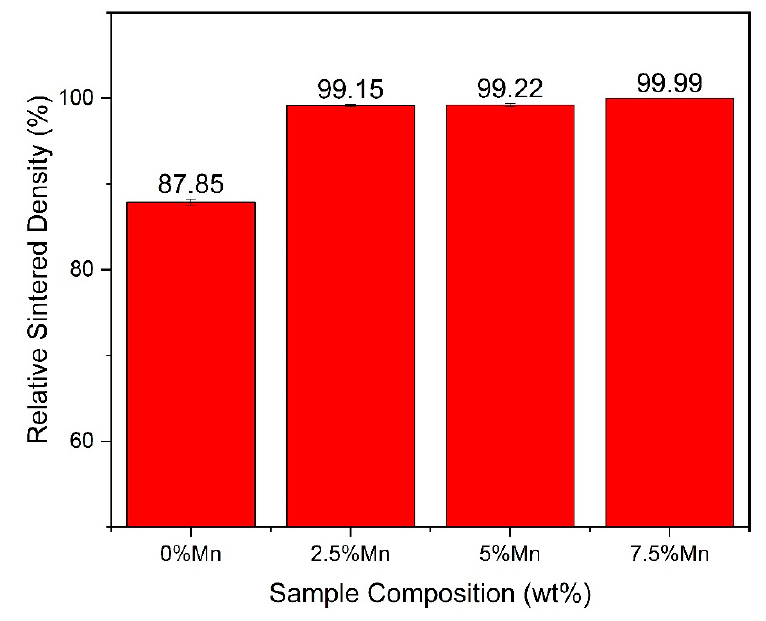
Figure 2. Relative sintered densities of the Ti-48Al-2Cr-2Nb- x Mn ( x —0, 2.5, 5, 7.5 wt.%) alloys. Table 2. Density of the Ti-48Al-2Cr-2Nb- x Mn ( x —0, 2.5, 5, 7.5 wt.%) alloys. Composition Theoretical Density (g / cm 3